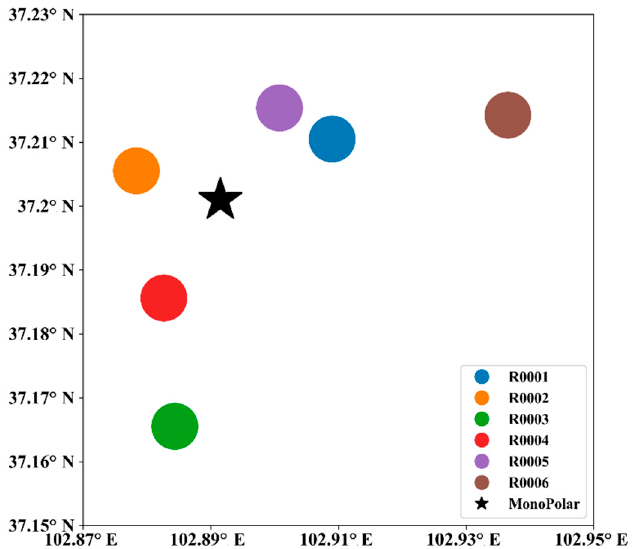
Figure 6. Location map of precipitation gauge stations and experimental device in Wushaoling.